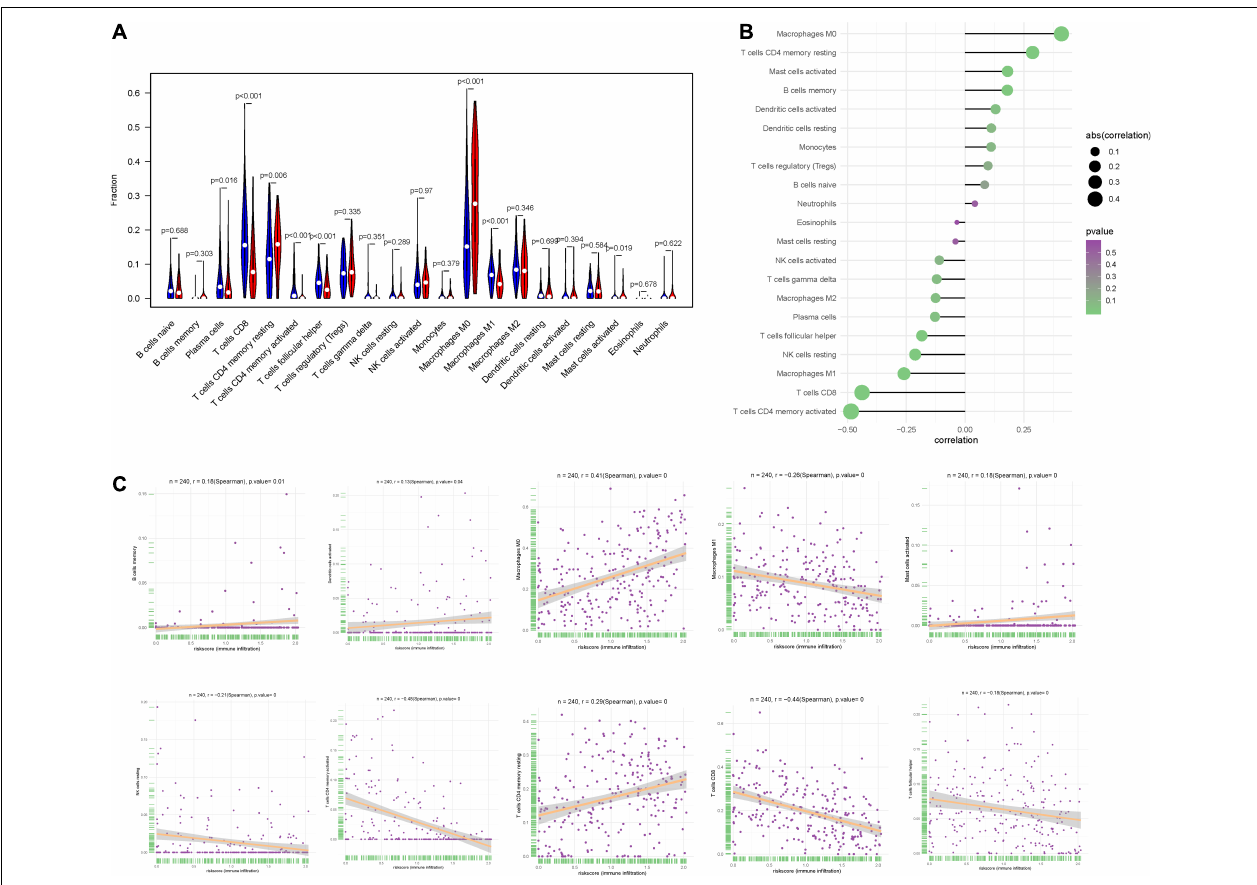
FIGURE 8 | Correlation between IRPS and immune cell infiltration. (A) The landscape of immune cell infiltration in low-risk and high-risk groups. Th low-risk and high-risk groups are represented via blue and red violin, respectively. (B) The association between IRPS and immune cell infiltration. (C) The association between IRPS and each type of immune